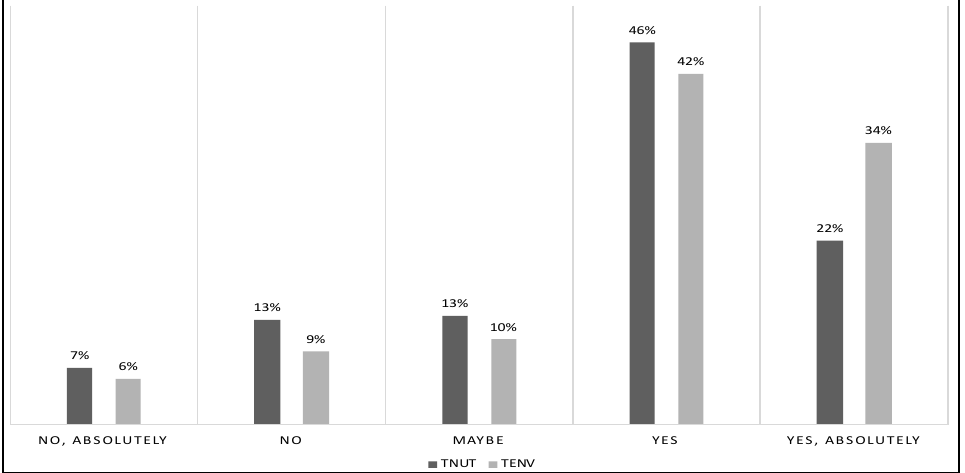
Figure 1. Distribution of the Technophobia Index (TFI).